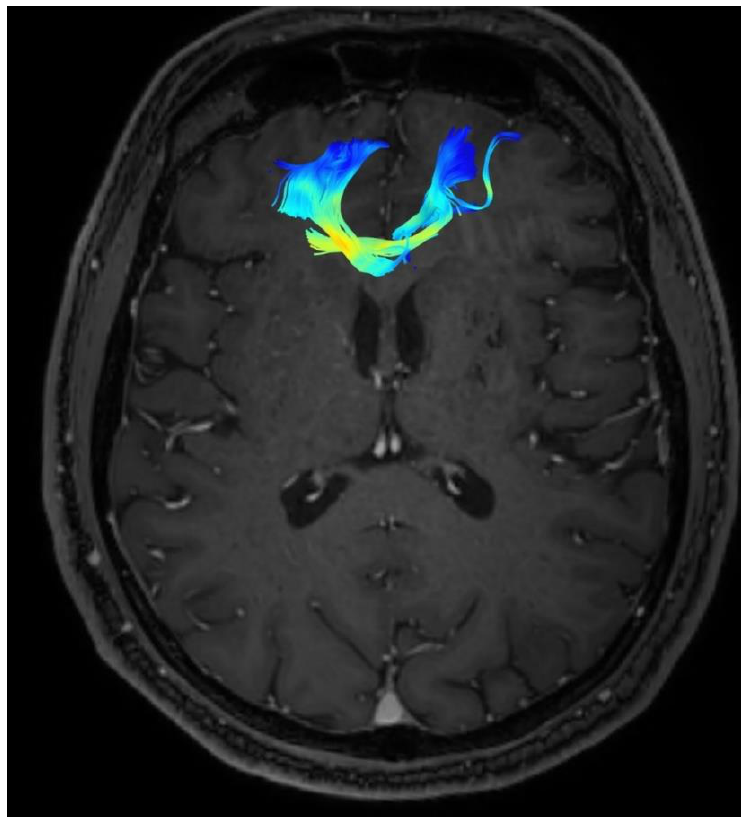
Figure 2. Forceps minor before cingulotomy.